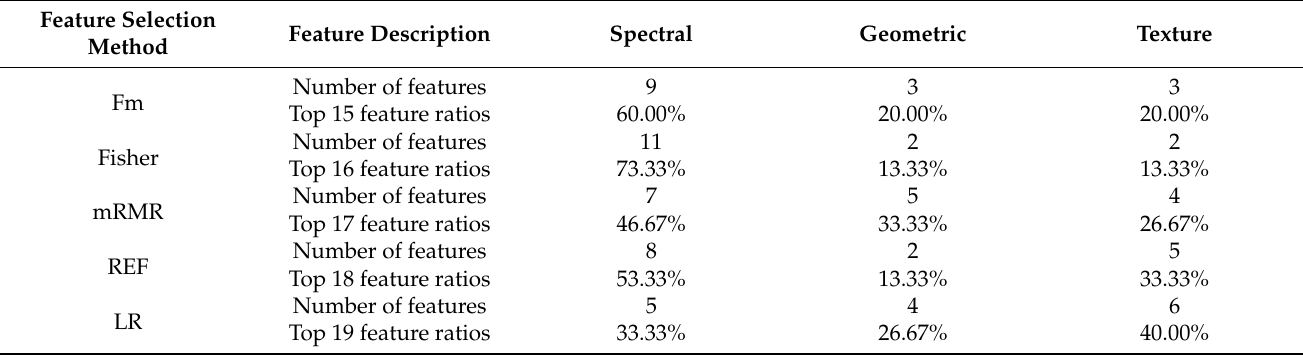
Table 3. Summary of the characteristics in the different categories of the top 15 characteristics according to Table